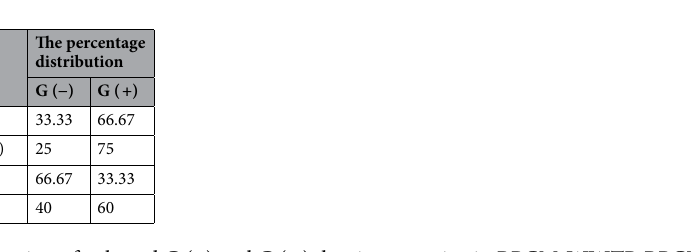
Table 4. The percentage distribution of cultured G (−) and G ( +) dominant strains in RPCM-WWTP. RPCM, recycled paper and cardboard mill; WWTP, wastewater treatment plant.